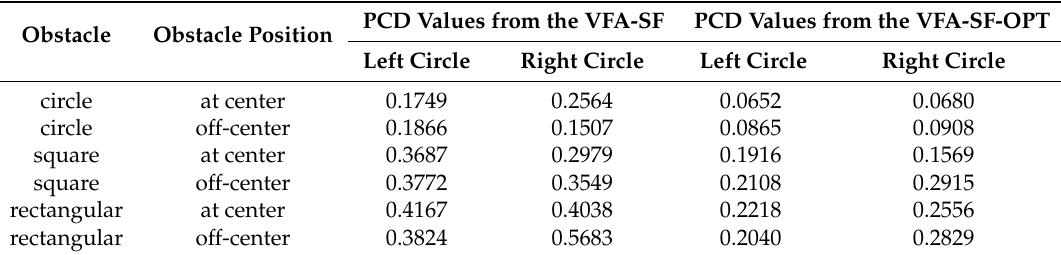
Table 5. PCD values calculated from red dashed circle in Figures 7–9 for three typical obstacle